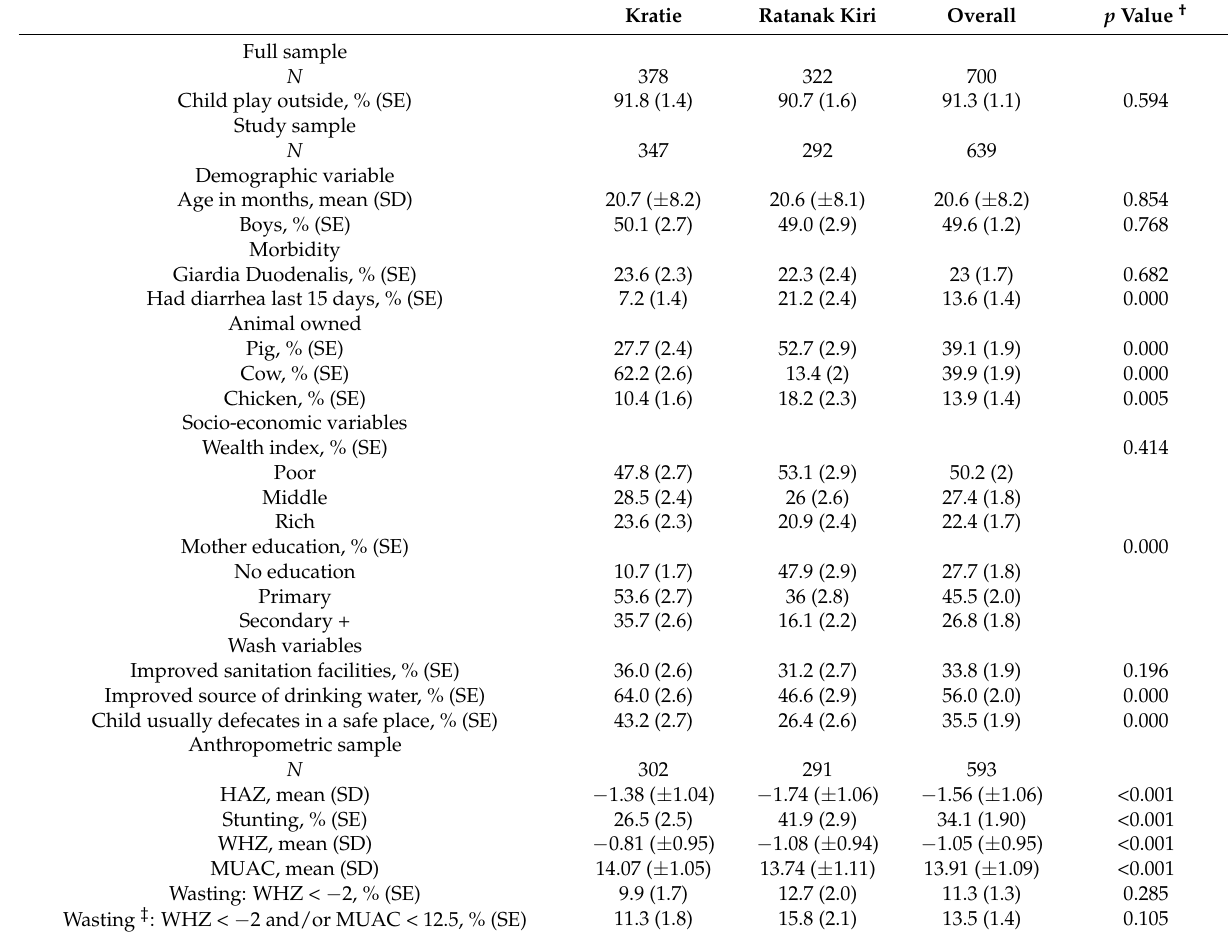
Table 1. Summary of the selected sample